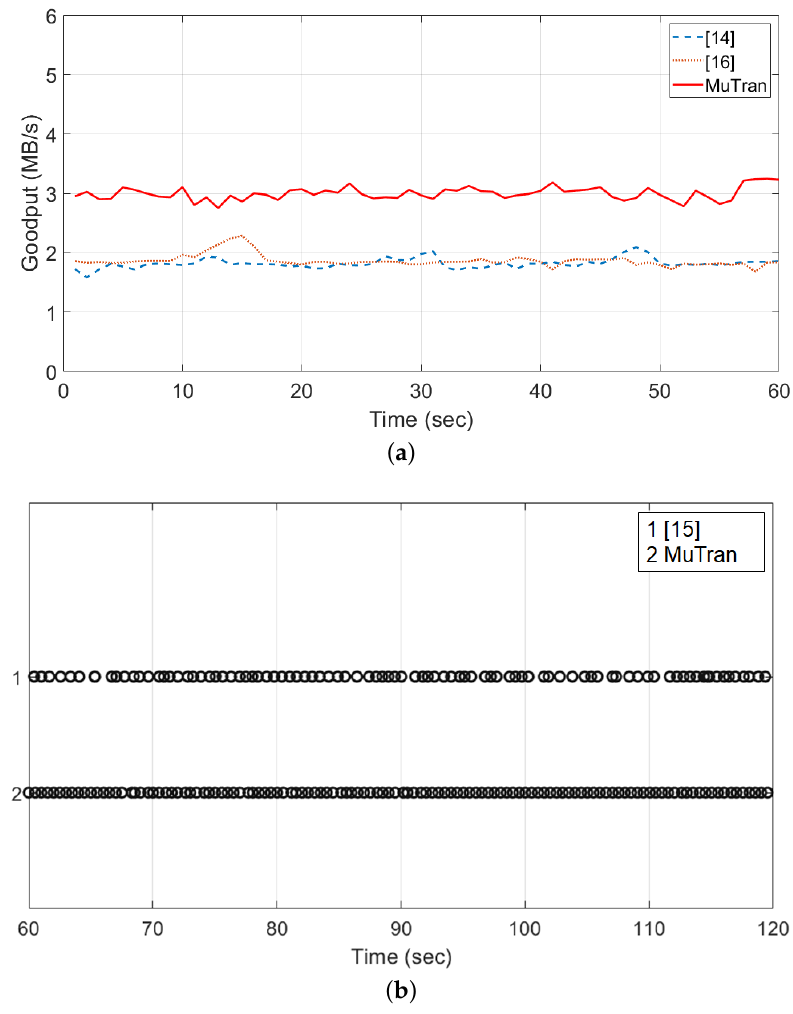
Figure 15. The comparison between the related techniques and MuTran . ( a ) The goodput perfor- mances of the data packet transmission of the related techniques [14,16] and MuTran . ( b ) Arrival moments of control packets in a low-quality communication situation when using the related tech- nique [15] and MuTran